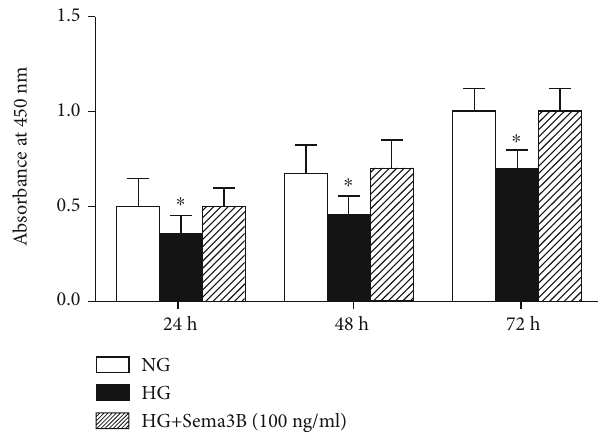
Figure 3: E ff ects of Sema3B on BMSC proliferation under HG treatment. The proliferation of BMSCs cultured under HG conditions was analyzed by CCK-8 assays at 24, 48, and 72 h. The results are represented the mean ± SEM ( n = 3 ). ∗ P < 0 : 05 compared to the other